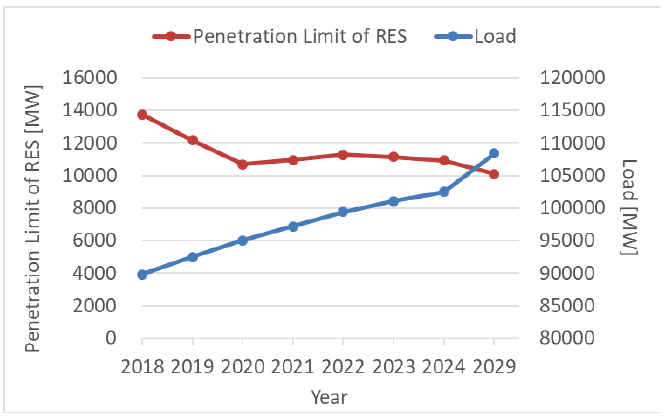
Figure 6. Penetration limit of RES calculated using the primary frequency control.